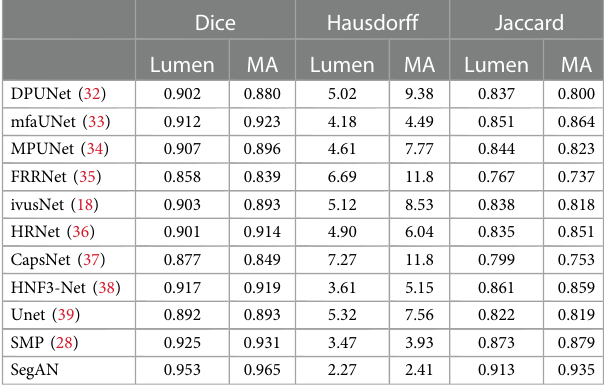
TABLE 2 Comparison of SegAN and state-of-the-art methods.